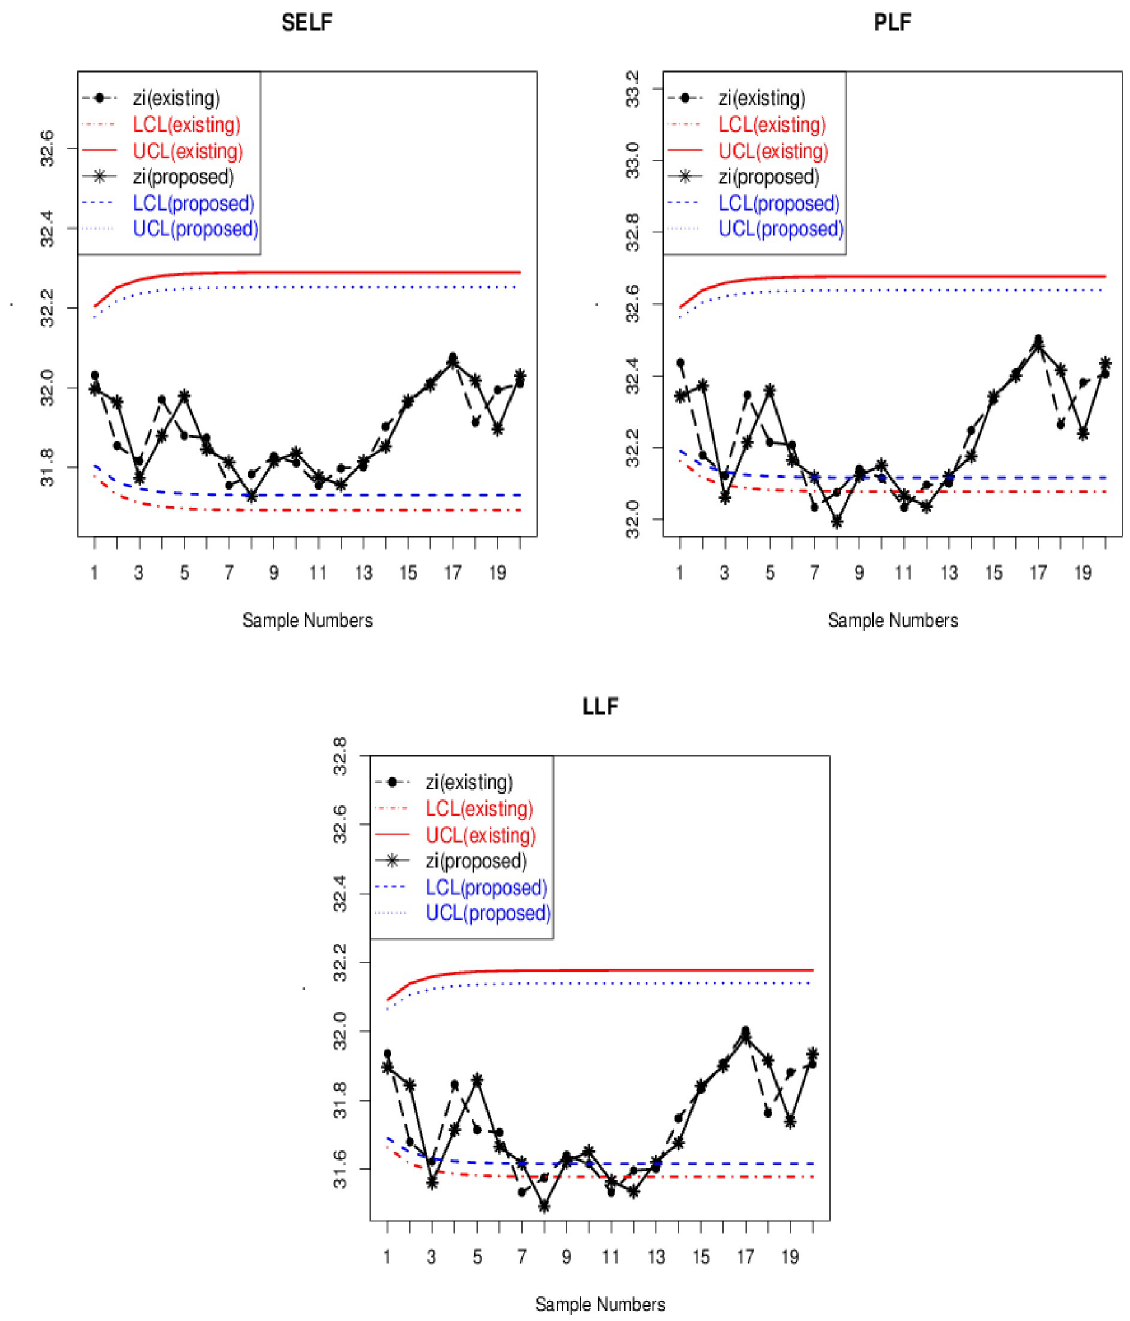
Fig 7. Phase-II graphical display of real-life data of reamed holes in metal of proposed Bayesian modified-EWMA chart and existing Bayesian EWMA under SELF and PLF. distribution of mean μ of the golf ball bounce to obtained posterior predictive distribution for the monitoring of golf ball bounce. Fig 8 shows the existing Bayesian EWMA and the proposed Bayesian Modified-EWMA control chart under various loss functions at λ = 0.15. The EWMA statistic and the Modified-EWMA statistic are plotted to their corresponding control limits for